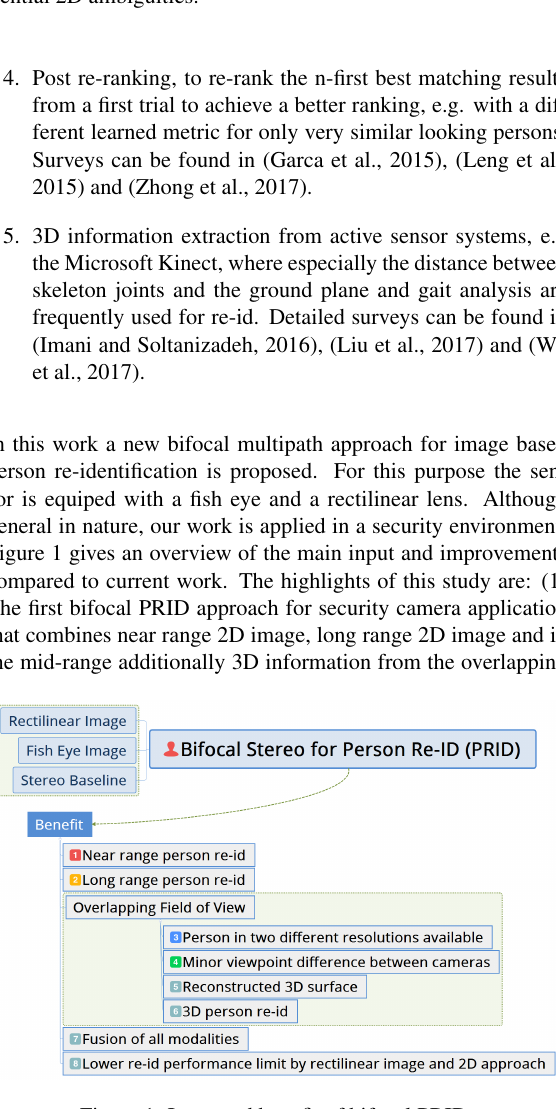
Figure 1. Input and benefit of bifocal